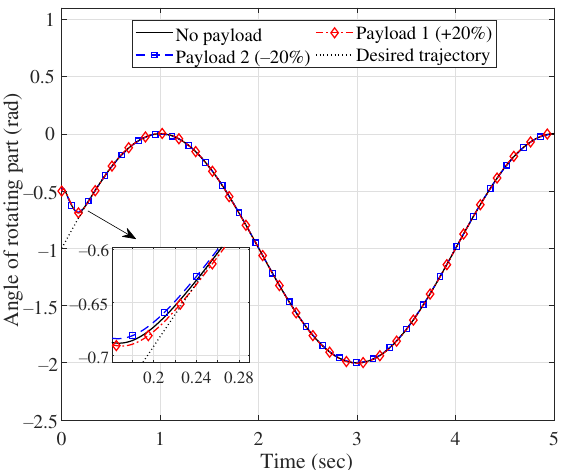
Figure 17. Angle of rotating part (Group